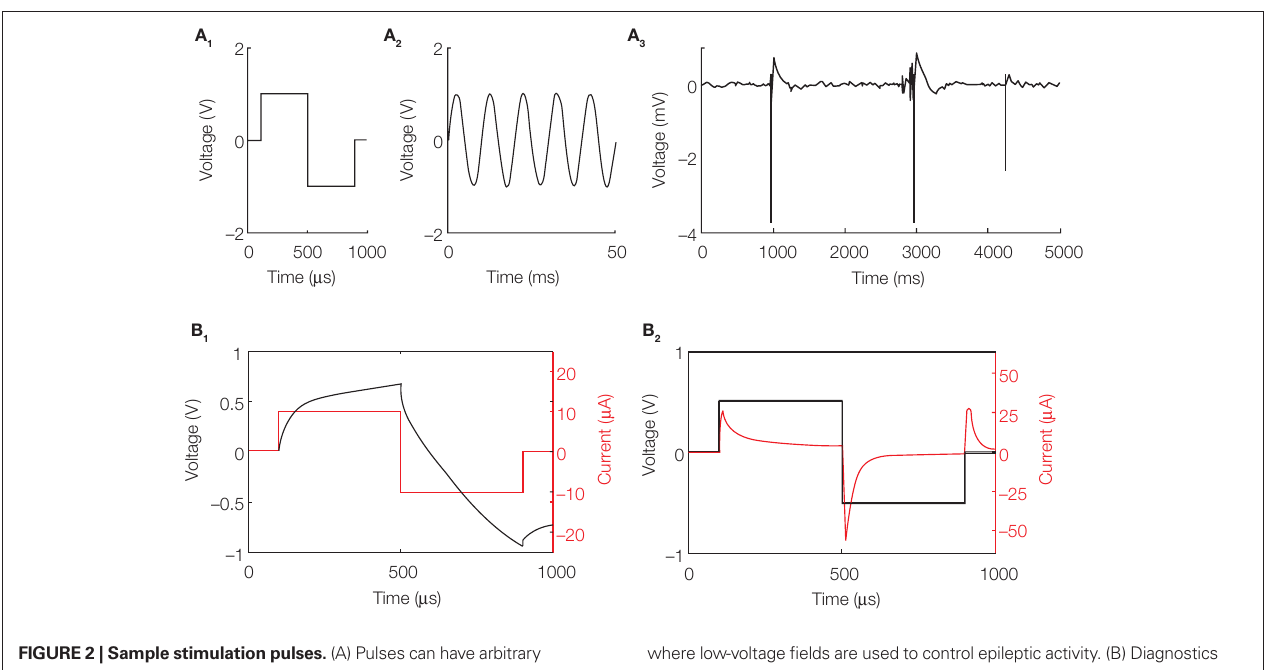
Figure 2 | Sample stimulation pulses. (A) Pulses can have arbitrary waveforms, such as biphasic pulses (A1), sine waves (A2), or even playing back previously recorded local field potentials (A3). The data from (A3) was obtained from an epileptic animal and shows several large-amplitude interictal spikes (de Curtis and Avanzini, 2001). How such low-voltage fields influence neuronal networks is an open question; for example, see McCormick and Contreras (2001), where ephaptic interactions are discussed, and Gluckman et al. (2001),